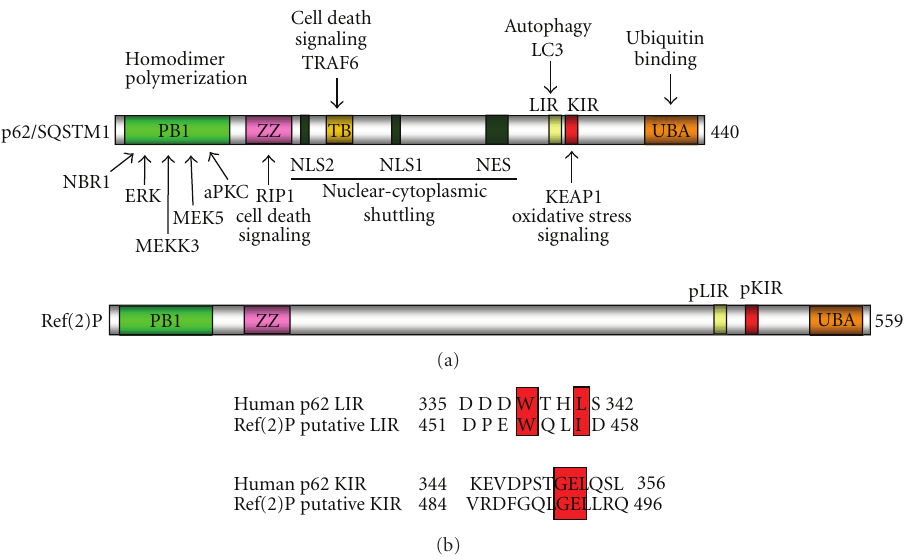
Figure 1: Schematic presentation of functional and structural domains of p62 and its Drosophila orthologue, Ref(2)P. (a) p62 consists of a PB1 domain (Phox and Bem1p domain) which is responsible for the interaction with the autophagy receptor NBR1 and the protein kinases ERK, MEKK3, MEK5, PKC ζ , and PKC λ / ι . The PB1 domain is followed by a ZZ-type zinc finger domain which contains the binding site for RIP1 and a TB domain which harbors the binding site of TRAF6. Nuclear localization signals (NLSs) and nuclear export signal (NES) are also present. p62 contains a LIR (LC3-interacting region) and a KIR (KEAP1-interacting region) motif and a C-terminal UBA (ubiquitin associated) domain responsible for binding to ubiquitin. Ref(2)P has similar structural and functional domains compared to p62. It consists of a PB1 domain which is followed by a ZZ-type zinc finger domain and a C-terminal UBA domain responsible for binding to ubiquitin. Ref(2)P also contains putative LIR and KIR motifs. (b) Bioinformatic prediction of Ref(2)P’s putative LIR and KIR motifs and alignment with human p62’s motifs. The functional roles of putative LIR and KIR motifs of Ref(2)P have to be tested experimentally.